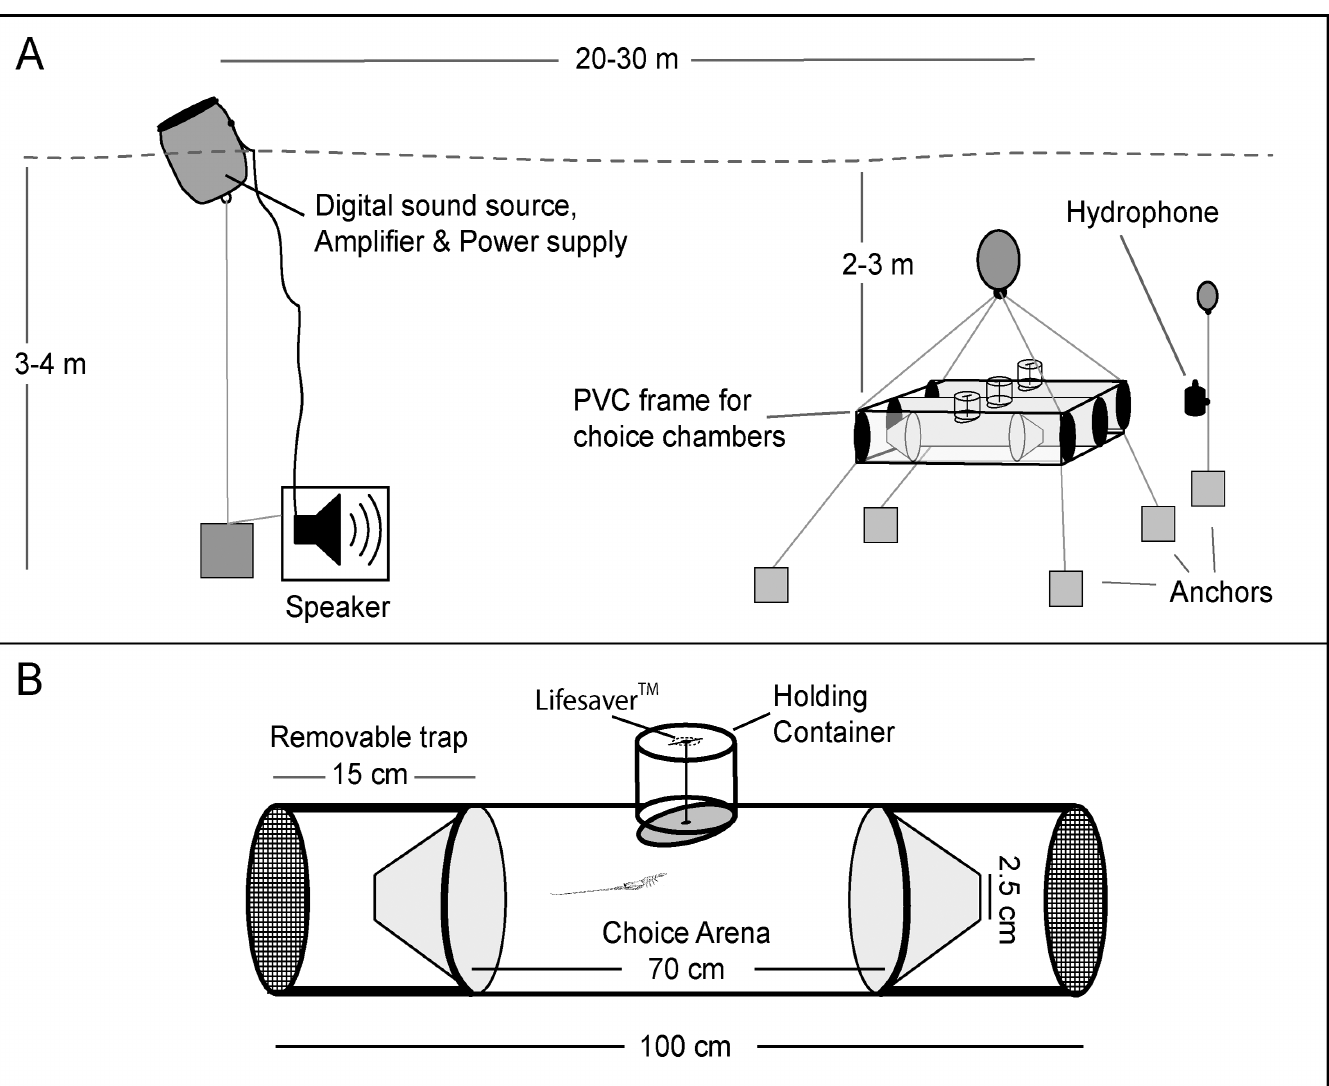
Fig 2. Experimental set up and choice chamber. (A) Schematic of experimental set up, and (B) behavioural choice chamber